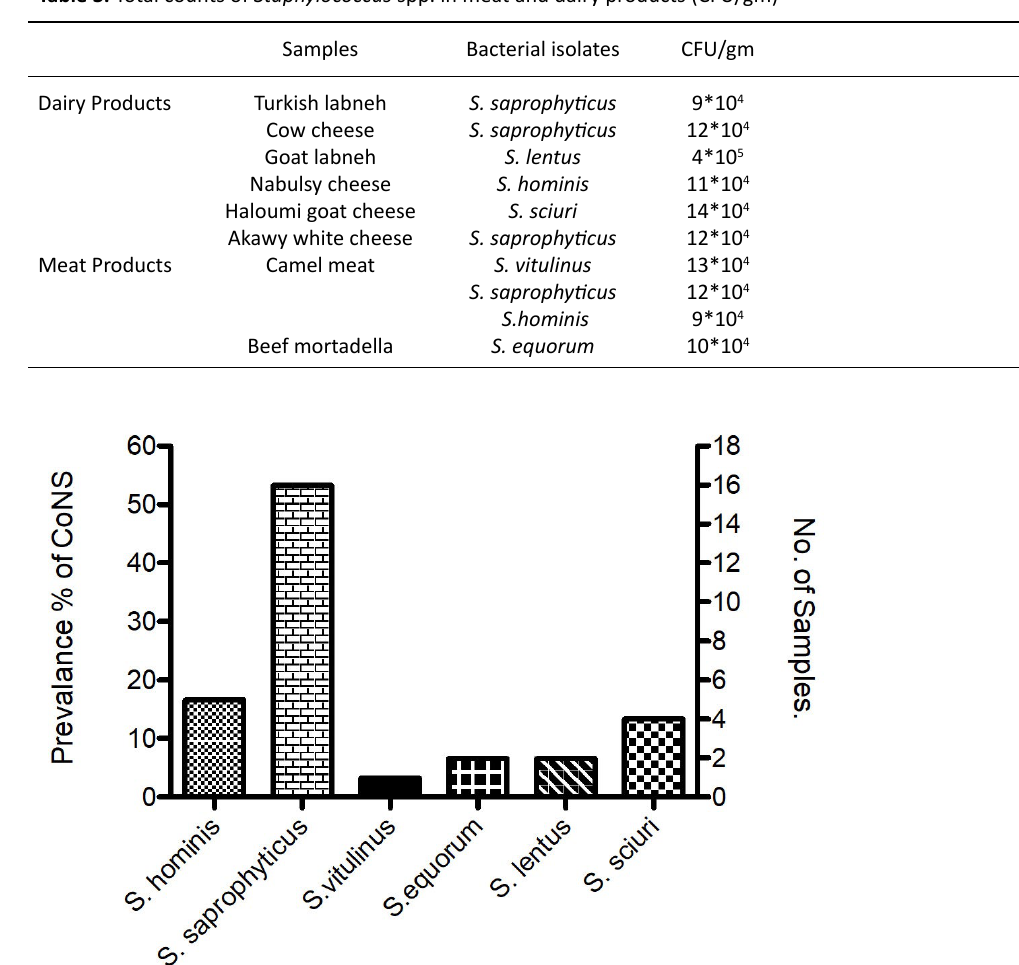
Fig. 1. Prevalence rate of different CoNS isolated from targeted